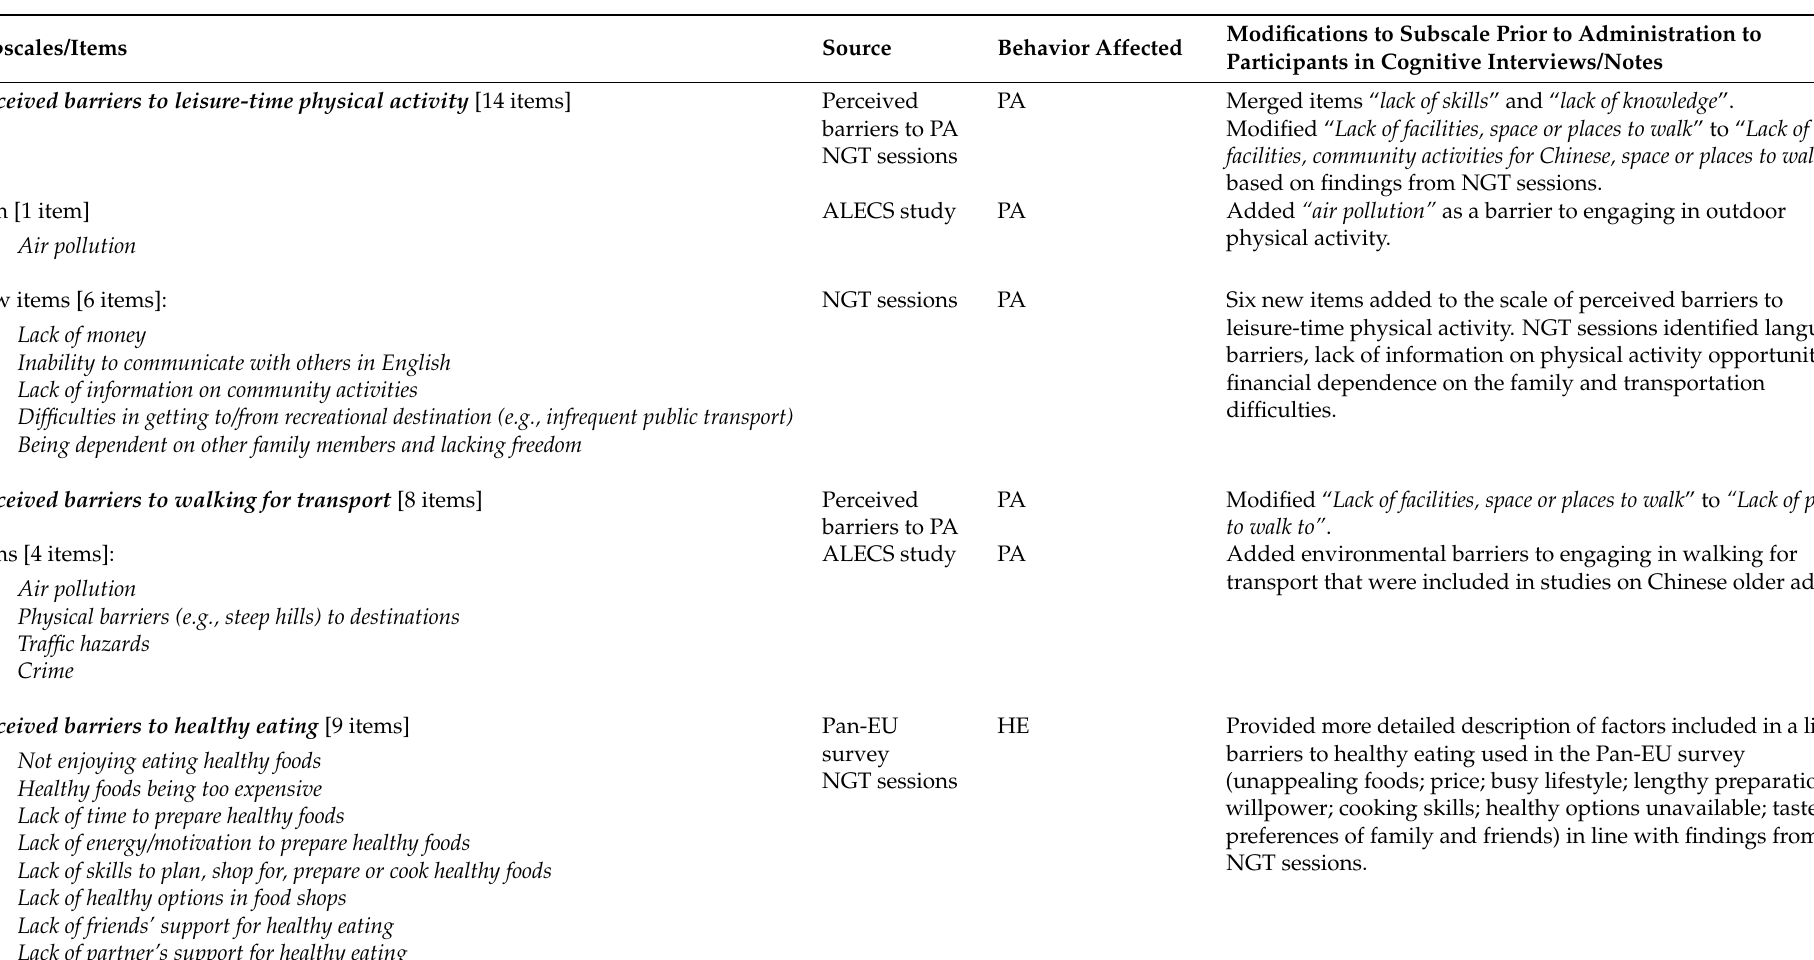
Table 3. Initial questionnaire items of perceived barriers to engagement in, physical activity, healthy eating, and socializing appropriate for older Chinese immigrants to Australia: content, sources of items, and modifications prior to administration to participants (Perceived barriers to Engaging in Health-Enhancing Behaviors